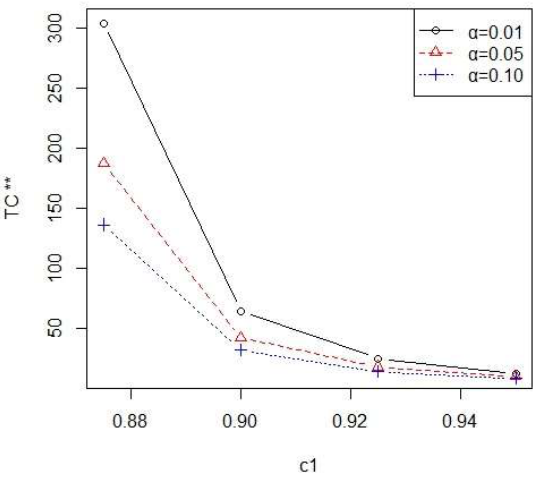
Figure 7. Minimum total cost curve for α = 0.01, 0.05, 0.1 at β = 0.25 and p = 0.05.